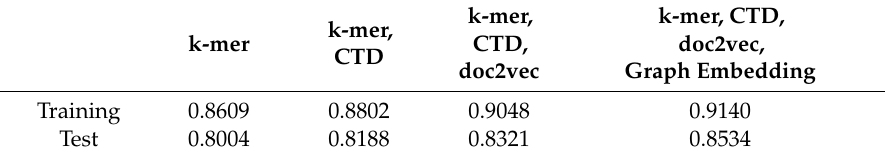
Table 1. E ff ects of feature information in terms of prediction